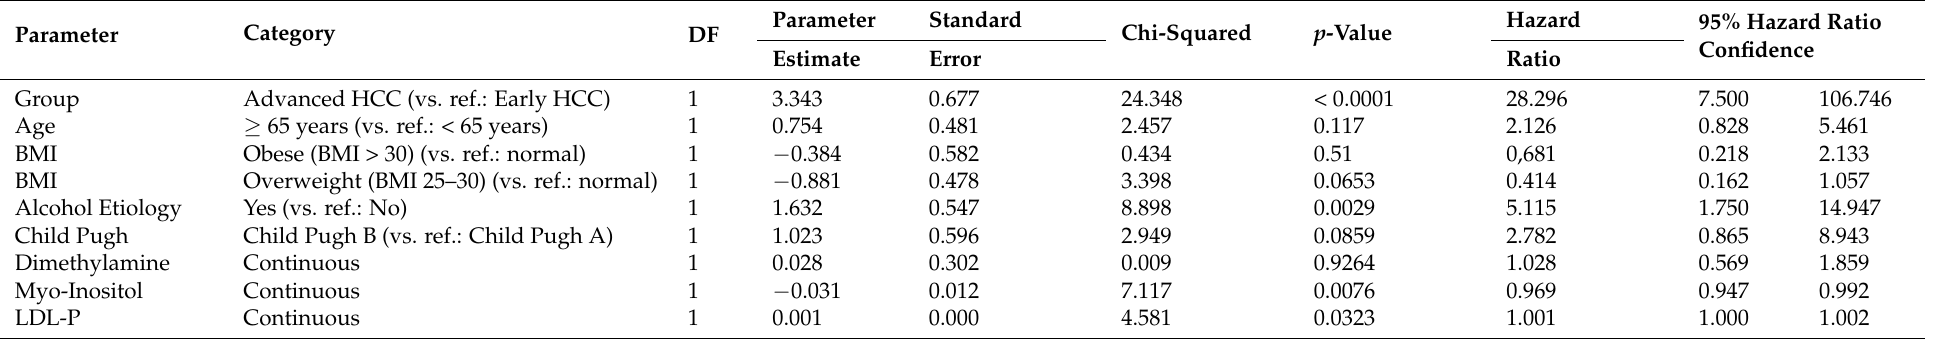
Table 6. Multivariate Cox proportional hazards model with the overall survival as the outcome variable. BMI = body mass index; DF = degrees of freedom; HCC = hepatocellular